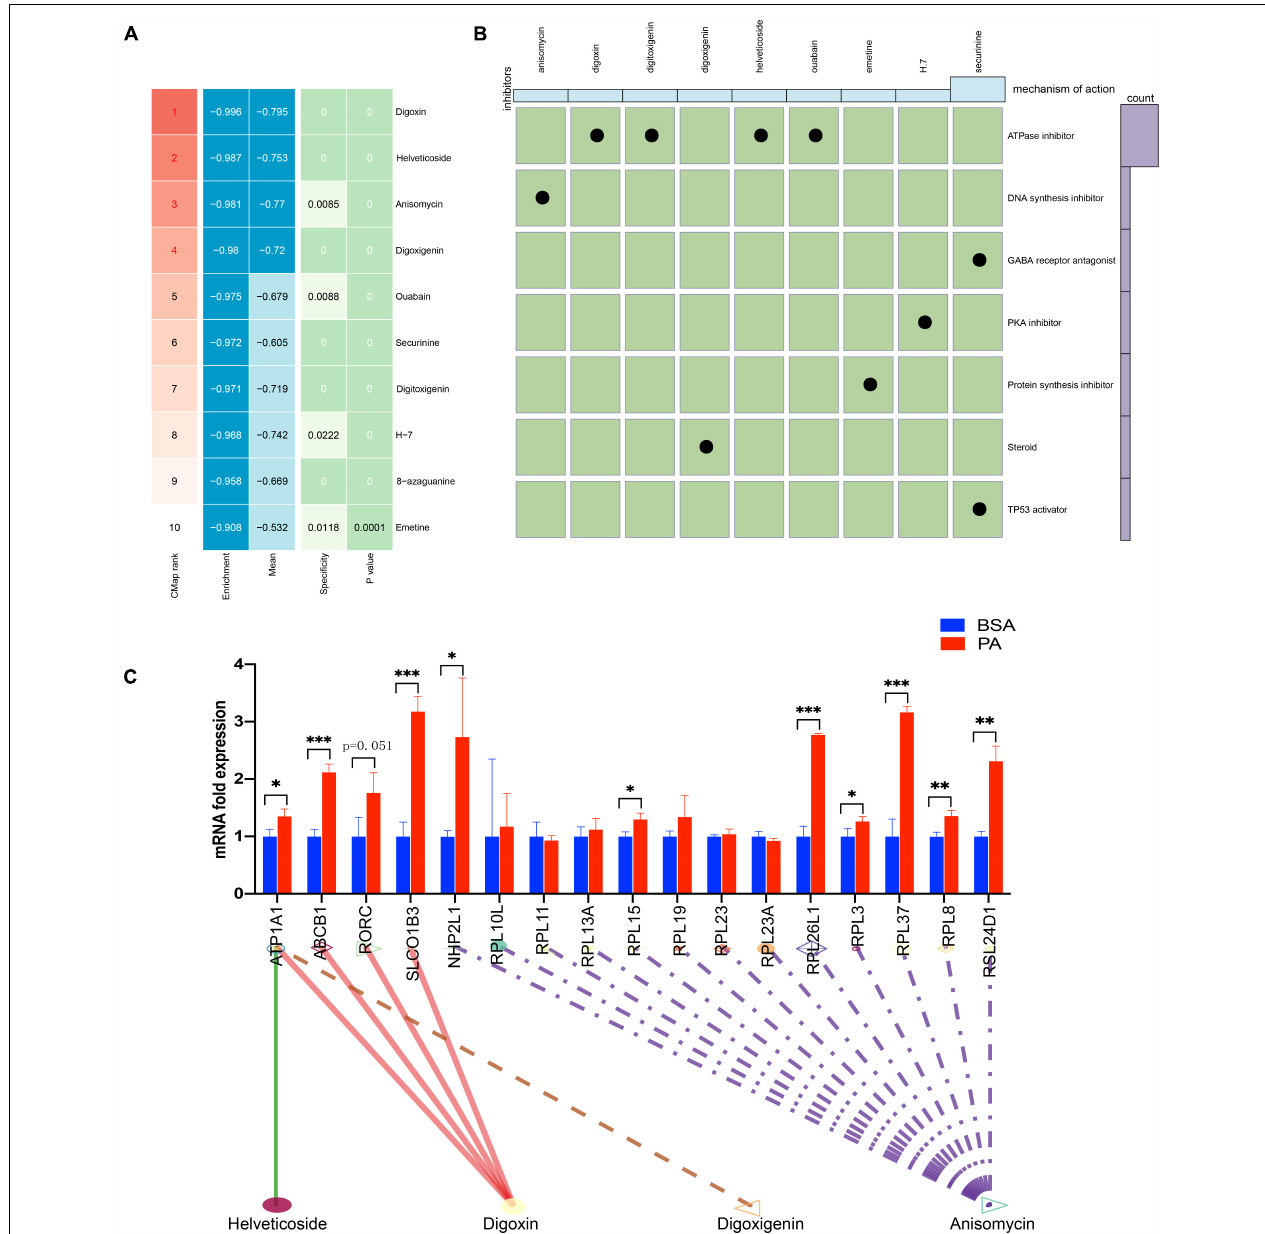
FIGURE 4 | CMap analysis of potential therapeutic drugs for NAFLD. (A) Results of CMap analysis for differentially expressed genes. (B) Molecular action of potential therapeutic drugs. (C) Expression of 17 drugs target genes in HepG2 cell after stimulated by palmitic acid. * p < 0.05, ** p < 0.01 and *** p <